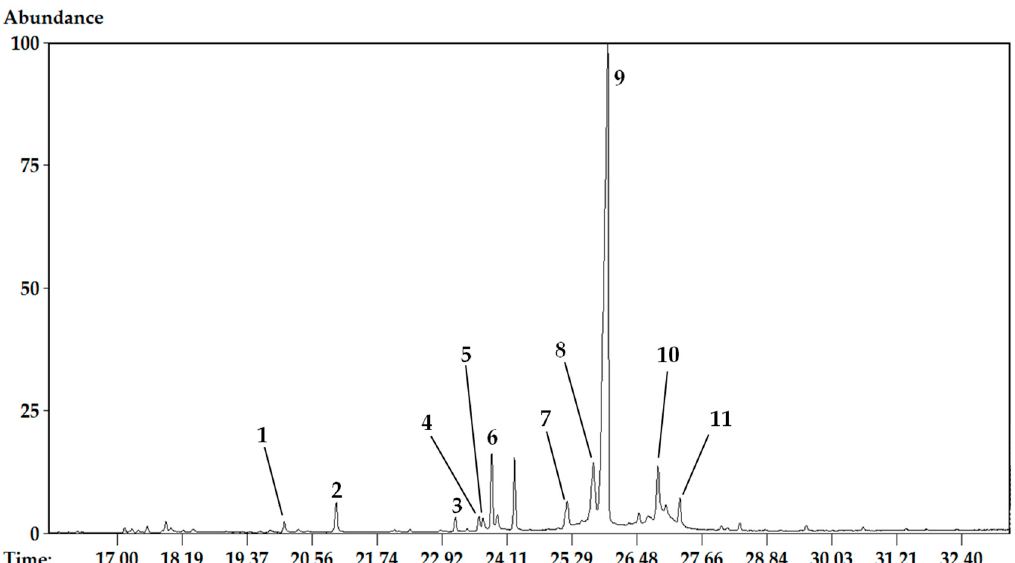
Figure 1. GC chromatogram of H. cardenasianus extract showing the alkaloids identified by MS. ( 1 ) Ismine, ( 2 ) 5,6-Dihydrobicolorine, ( 3 ) Unknown, ( 4 ) Galanthindole, ( 5 ) Anhydrolycorine, ( 6 ) Unknown, ( 7 ) 11,12-dehydro anhydrolycorine, ( 8 ) Haemanthamine, ( 9 ) Tazettine, ( 10 ) Haemanthidine/6-epi-haemanthidine, ( 11 ) Lycorine.